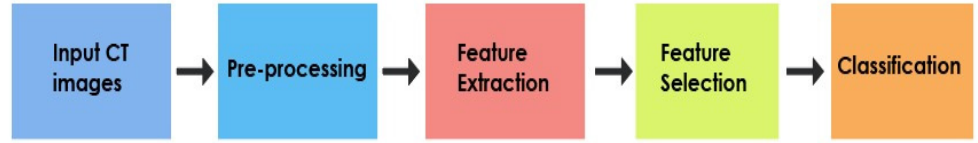
Figure 2. Outline of the proposed technique.